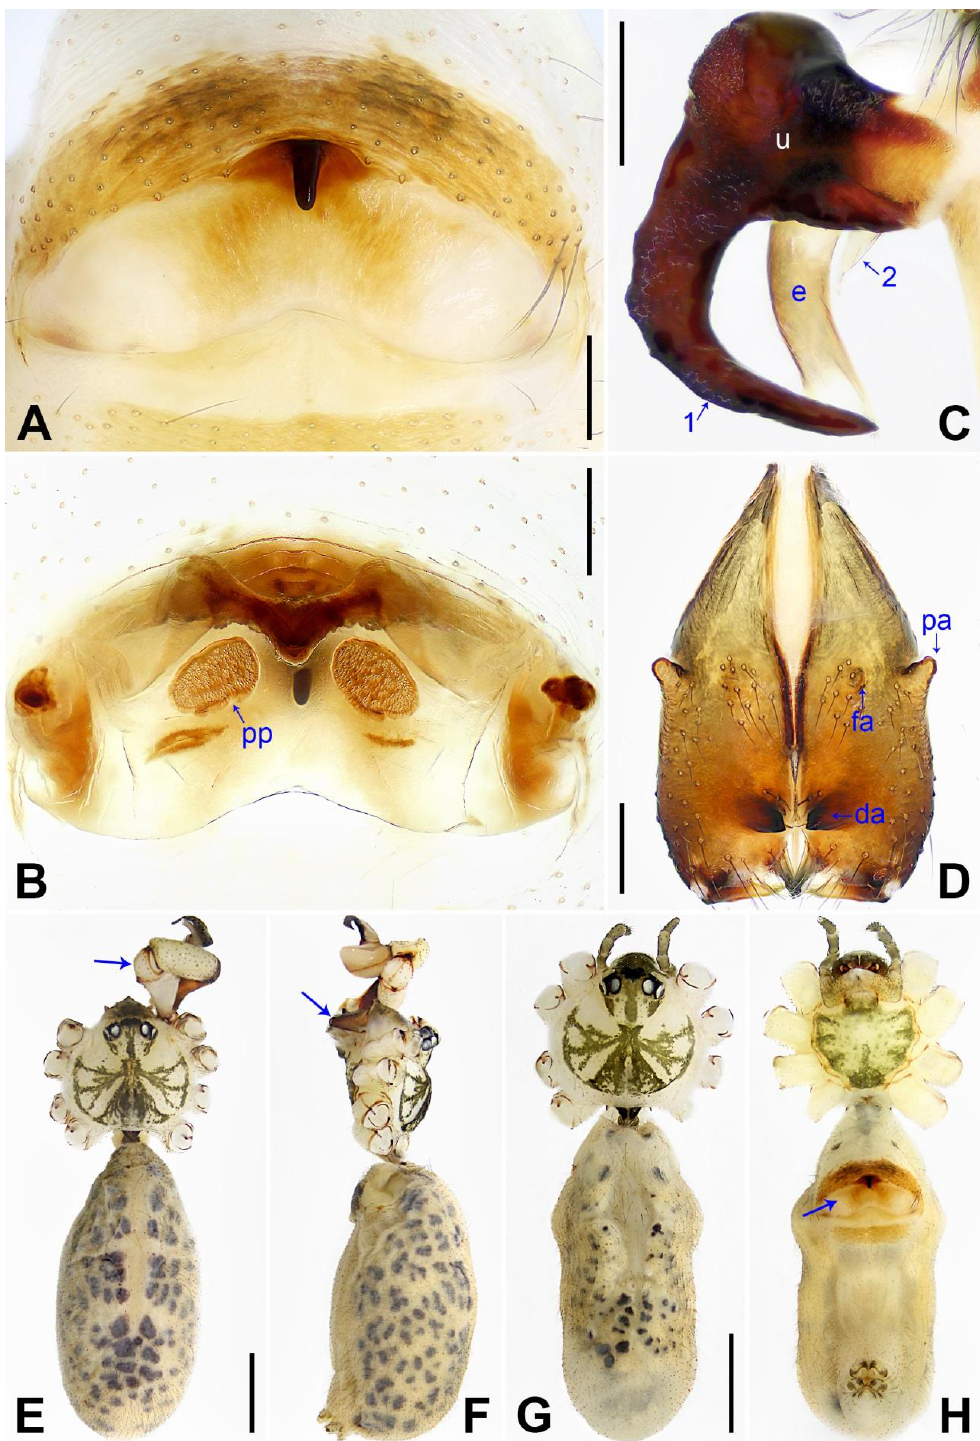
Figure 4. Pholcus jiaocheng sp. nov., holotype male ( C – F ) and paratype female ( A , B , G , H ): ( A ) epigyne, ventral view; ( B ) vulva, dorsal view; ( C ) bulbal apophyses, prolateral view (arrow 1 points at slender distal apophysis, arrow 2 points at “pseudo-appendix”); ( D ) chelicerae, frontal view; ( E ), ( G ) habitus, dorsal view (arrow points at pedipalp); ( F ) habitus, lateral view (arrow points at chelicerae); ( H ) habitus, ventral view (arrow points at epigyne). da = distal apophysis, e = embolus, fa = frontal apophysis, pa = proximo–lateral apophysis, pp = pore plate, u = uncus. Scale bars: ( A – D ) = 0.20 mm; ( E – H ) = 1.00 mm.